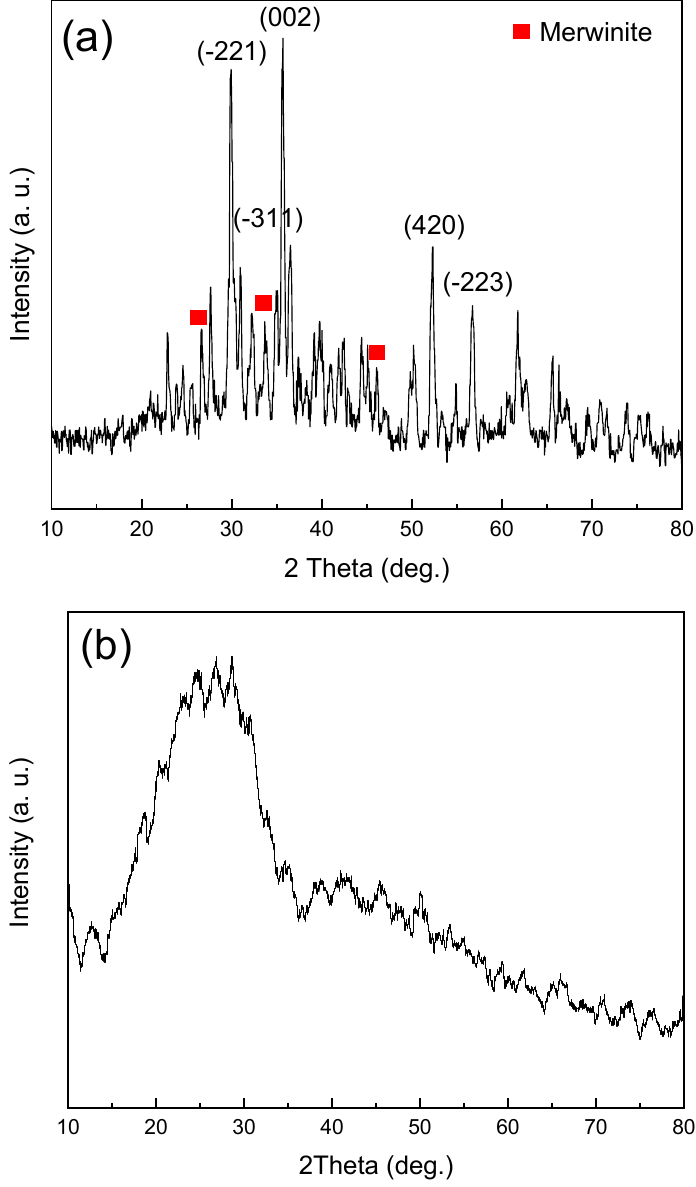
Figure 2. XRD pattern of ( a ) diopside (DIO) nanoparticles after calcination at 800 °C and ( b ) glass ionomer powder.